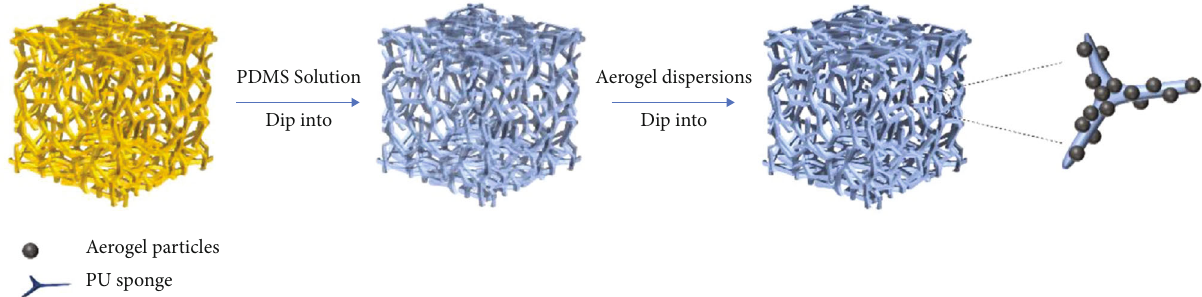
Figure 2: The vinyl modi fi ed silica aerogel particles were bonded to the sponge skeleton surface using